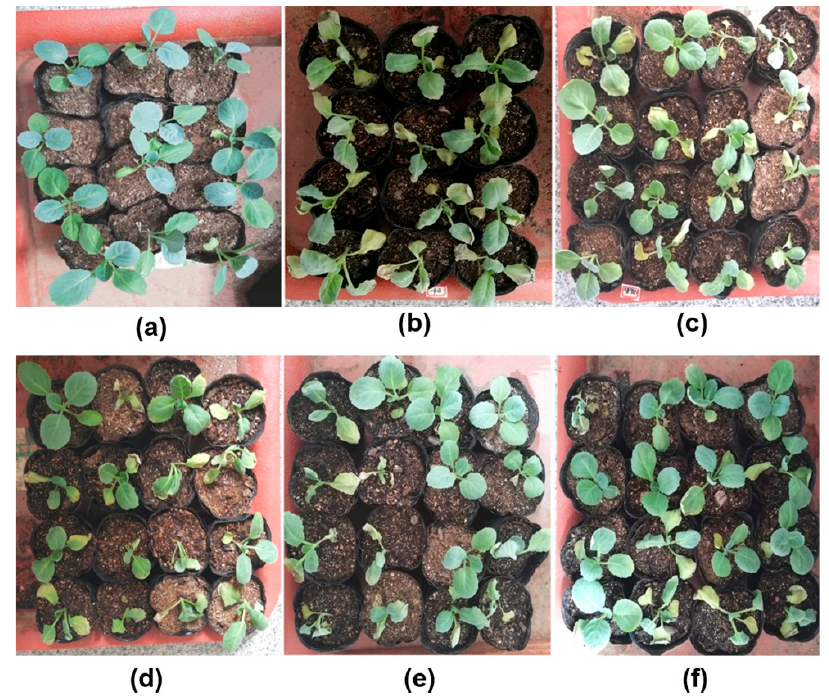
Table 3. Control effects of B5 and B6 on cabbage Fusarium wilt. Figure 4. The disease symptoms of cabbage seedlings under different treatments. ( a ) Treatment A, which refers to cabbage seedlings inoculated with sterilized distilled water as a control group; ( b ) Treatment B, which refers to cabbage seedlings inoculated with F. oxysporum only; ( c ) Treatment C, which refers to cabbage seedlings inoculated with F. oxysporum and watered with B5 suspension into soil; ( d ) Treatment D, which refers to cabbage seedlings inoculated with F. oxysporum and watered with B6 suspension into soil; ( e ) Treatment E, which refers to cabbage seedlings inoculated with the suspension, including F. oxysporum and B5; ( f ) Treatment F, which refers to cabbage seedlings inoculated with the suspension, including F. oxysporum and B6.